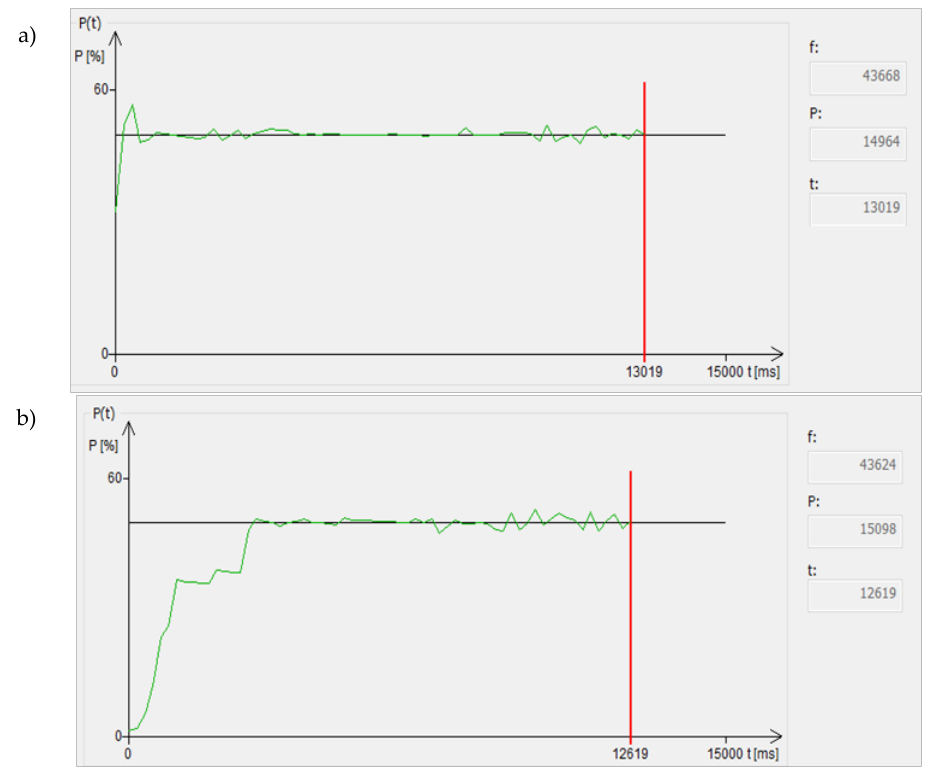
before any significant changes occurred in the load parameters. At a later stage of the process, when the system parameters began to change dynamically, the regulator was unable to maintain the set power, leading to the power oscillations of several percent we observed. Analysis indicates that eliminating the oscillations required at least a fourfold increase (to 4 kHz, so 0.25 ms) in the frequency of calling the regulating procedure.